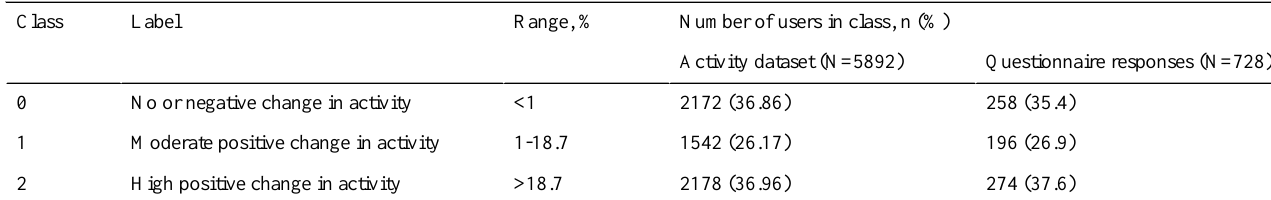
Table 2. Classification of physical activity behavior change based on percentage change in daily step count relative to the 3 months preregistration period. The number of samples in each class is shown for both the daily step count data and the combined questionnaire responses with daily step count. Number of users in class, n (%)Range,